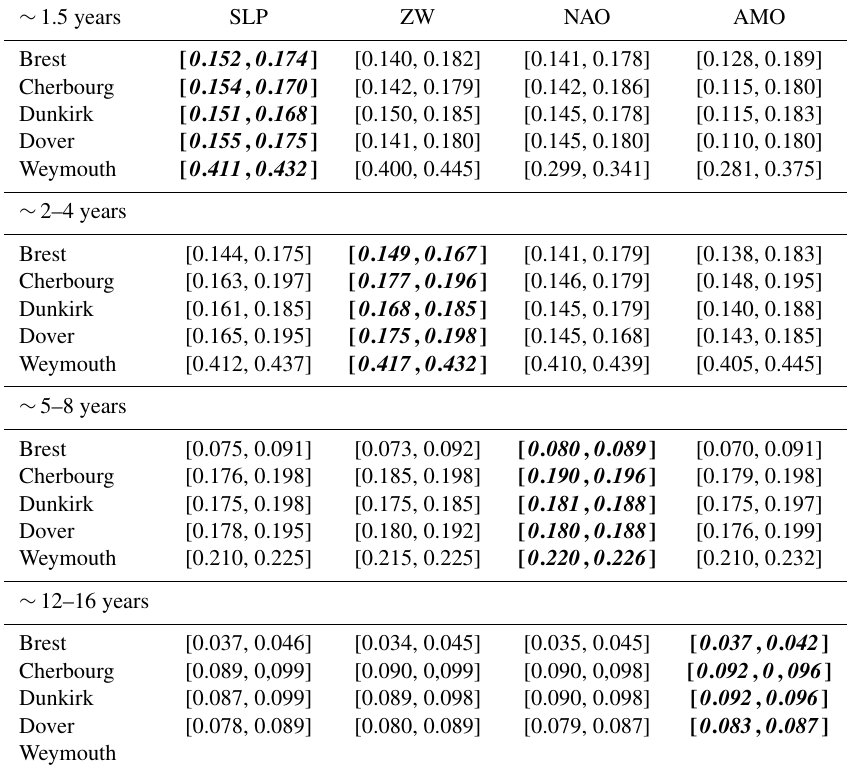
Table 3. Analysis of the statistical significance of the correlation between the spectral component of the extreme surges and the climate oscillation at each timescale for the different stations is shown. The 95% confidence intervals (applied for the maximum values) from the bootstrap technique are shown in square brackets. The most significant correlations, shown by the most limited (smaller) 95% CI between the lower and the upper bounds, are illustrated in italics. The lowest frequency of ∼ 12–16 years is not observed in